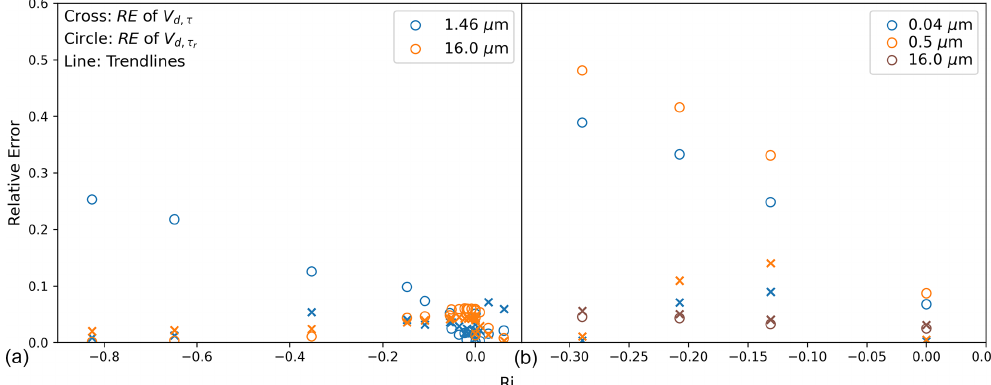
Figure A3. Comparison of relative error as a function of Ri , estimated by ZS14 scheme (circles) and the improved scheme (crosses) for Exp (1–20) (a) and Exp (24, 27, 30, 33) (b)